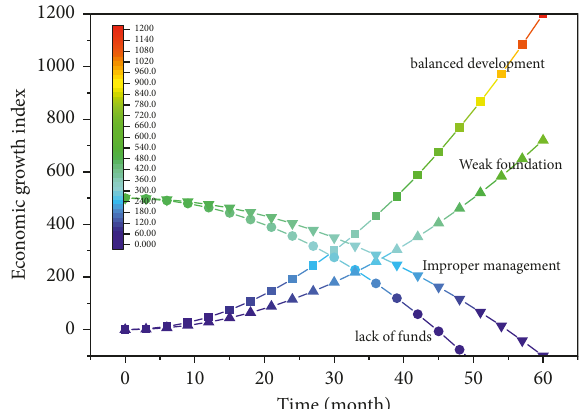
Figure 7: The development rate of low-carbon economy of four types of enterprises.